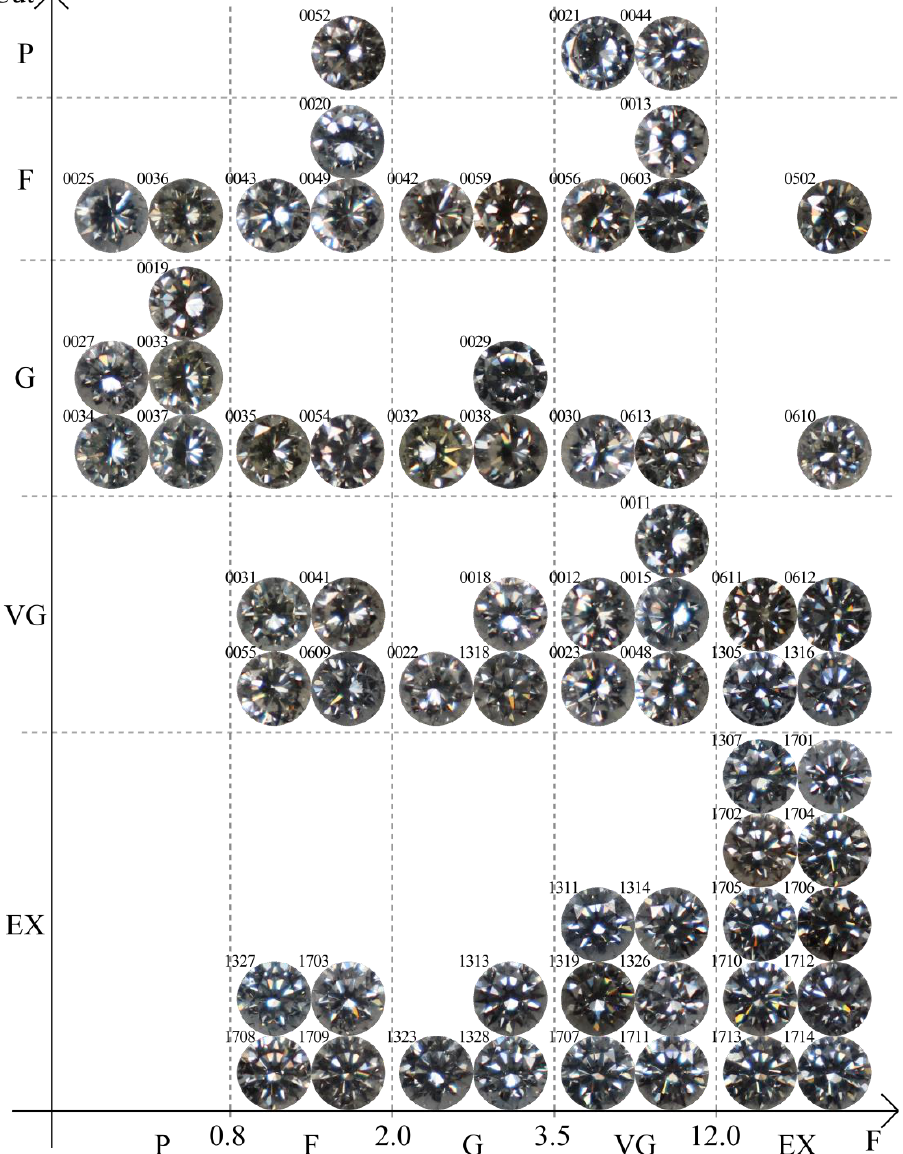
Figure 4. Diamond scintillation evaluation results. The larger the F, the stronger the diamond scintillation. This figure shows that the diamond scintillation is generally positively correlated with cut